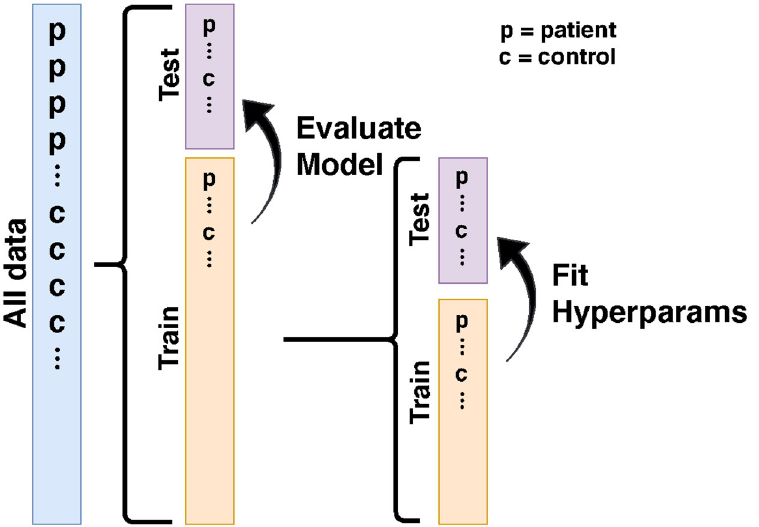
Fig 5. Nested cross-validation. We evaluate model quality using a nested k -fold cross validation scheme. At level-0, the input data is decomposed into k 0 shuffled groups and optimal hyperparameters are found for the level-0 training set. To avoid overfitting, the optimal hyperparameters are themselves evaluated using a cross-validation scheme taking place at level-1 of the decomposition, where each level-0 training set is further decomposed into k 1 = 3 shuffled groups. In the classification case, the training and test splits are stratified by diagnosis. For the ALS and WH data, k 0 = 10, while for the HBN and Cam-CAN data, k 0 = 5.